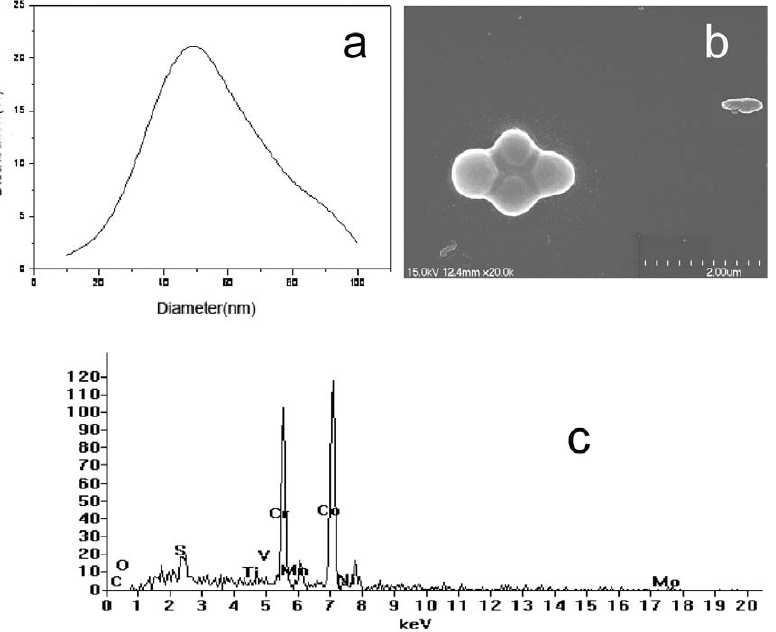
Figure 8. (a)Size distribution curve of wear particles (b)Image of aggregated CoCr wear particles (SEM, 6 20,000) (c) The elemental composition in the wear particles by EDS